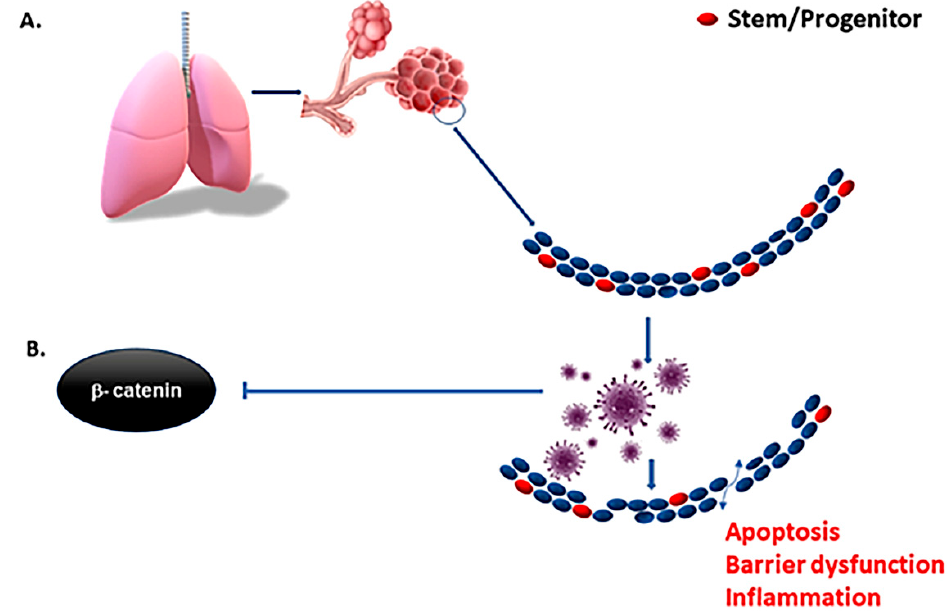
Figure 2. Early inhibition of interferons by SARS-CoV-2 and other viruses serve to suppress the innate immune response, resulting in rapid increases in cellular infection and spread before the adaptive immune response can develop. The depletion of resident stem cells by more virulent forms of viruses impedes the regenerative capacity of the tissue, and in turn increases the inflammatory context ( A ). Virulent forms of influenza suppress β -catenin nuclear localization ( B ) and downstream expression of interferons. Means of mitigating suppression of interferon and the innate immune response in the early phase of infection may reduce viral spread and preserve resident stem cells in the tissue of interest.